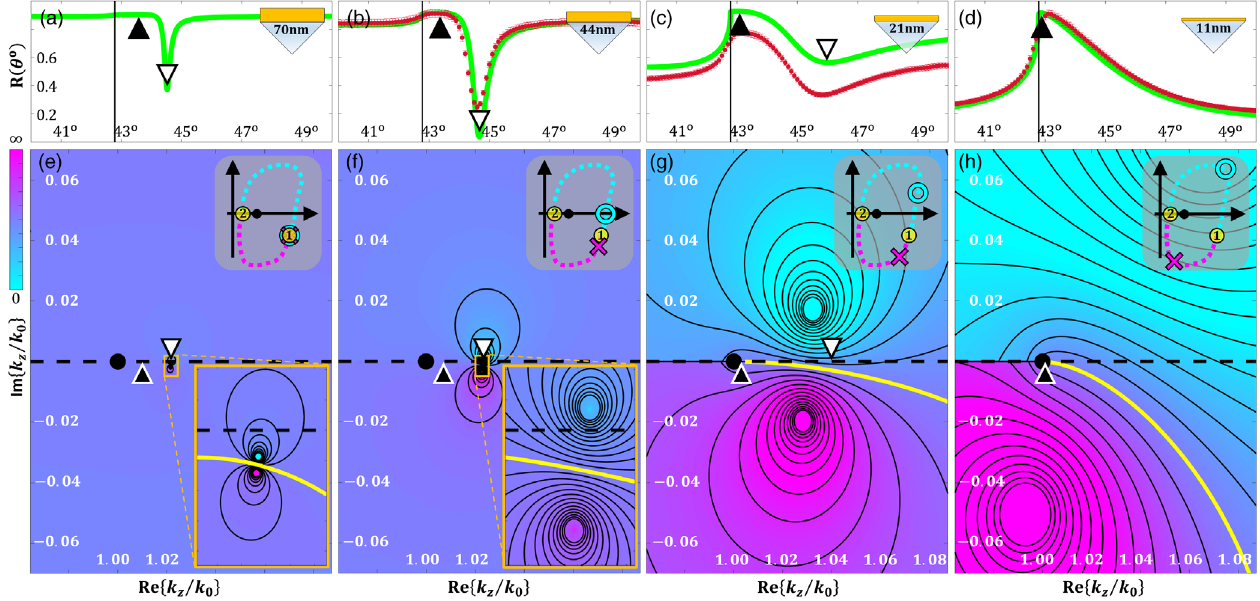
FIG. 4. Pairing of nonmodal (APP) and modal (SPP) plasmonic DOFs. (a) – (d) Measured (red) and predicted (green) reflectance of (a) 70, (b) 44, (c) 21, and (d) 11 nm gold films illuminated through a glass coupling prism as a function of incidence angle θ at illumination wavelength λ ¼ 800 nm. (e) – (h) Calculated reflection coefficient magnitude j r j of the respective films (log scale) for complex longitudinal wave vectors k z corresponding to the angular range in (a) – (d). Enlarged sections marked by orange rectangles. The long-range SPP and APP correspond to reflection pole (magenta) and zero (cyan) points, respectively. Constant j r j contour lines illustrate how the pole-zero pair projects onto the real axis (dashed black line) a reflectance peak-and-dip signature (black and white arrows). The angular shift between these two features arises from the tilt highlighted by a downward sloping j r j ¼ 1 line (yellow). Inset: Pole-zero locations along their joint closed-loop root locus as the film thickness decreases from ∞ → 0 (points 1 → 2 ), shown through the entire progression in Movie 4. Vertical black lines in (a) – (d) and black dots in (e) – (h) mark the critical angle ( k z ¼ k 0